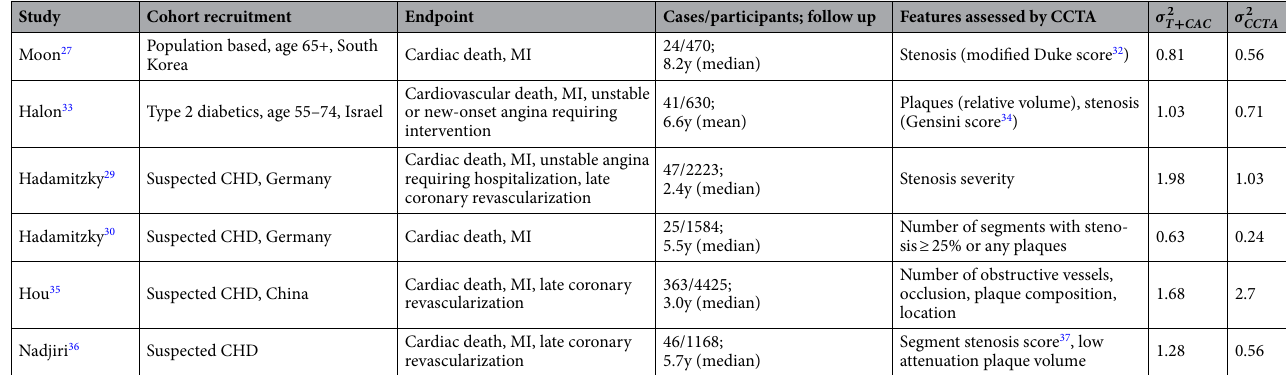
Table 2. Studies investigating the incremental prognostic value of coronary computed tomography angiography (CCTA). Estimated variances of the log risks refer to risk predicted by traditional risk factors and 2 coronary artery calcium (CAC) scoring ( σ T + CAC ) and to the additional variance obtained by CCTA imaging 2 ( σ CCTA ). CHD coronary heart disease, MI myocardial